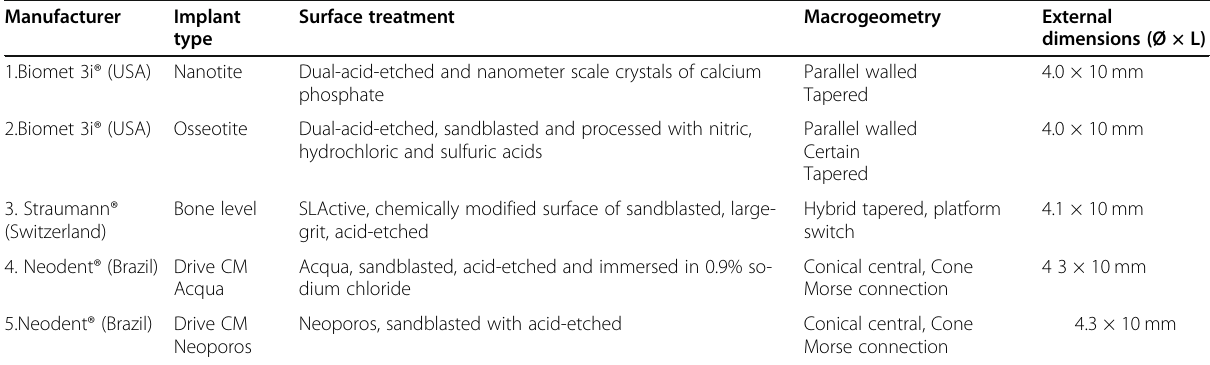
Table 1 Characteristics of dental implants evaluated according to manufacturer